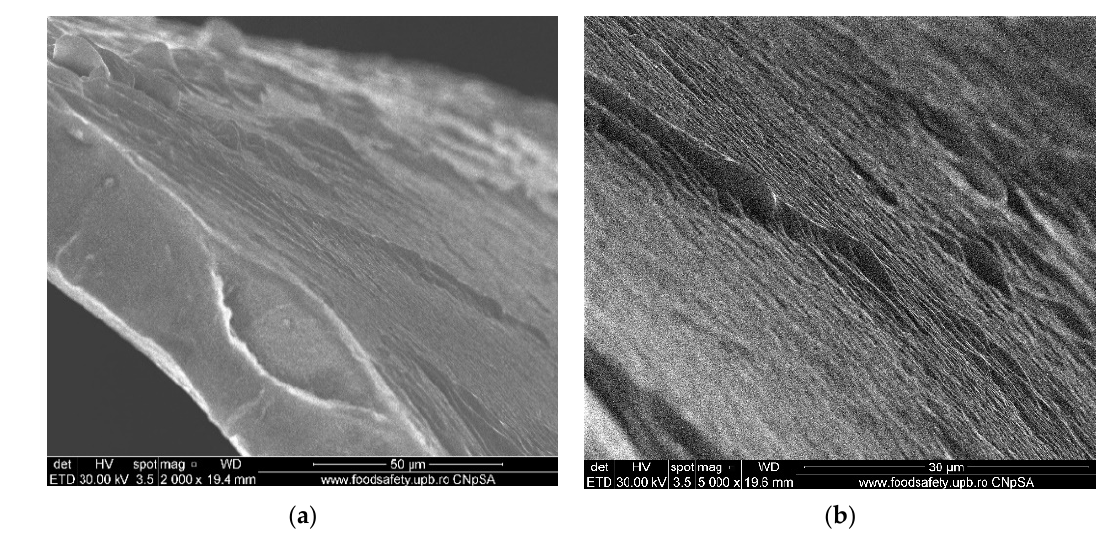
Figure 8. Morphology CA–PPM membranes: ( a ) membrane cross–section; ( b ) membrane surface.